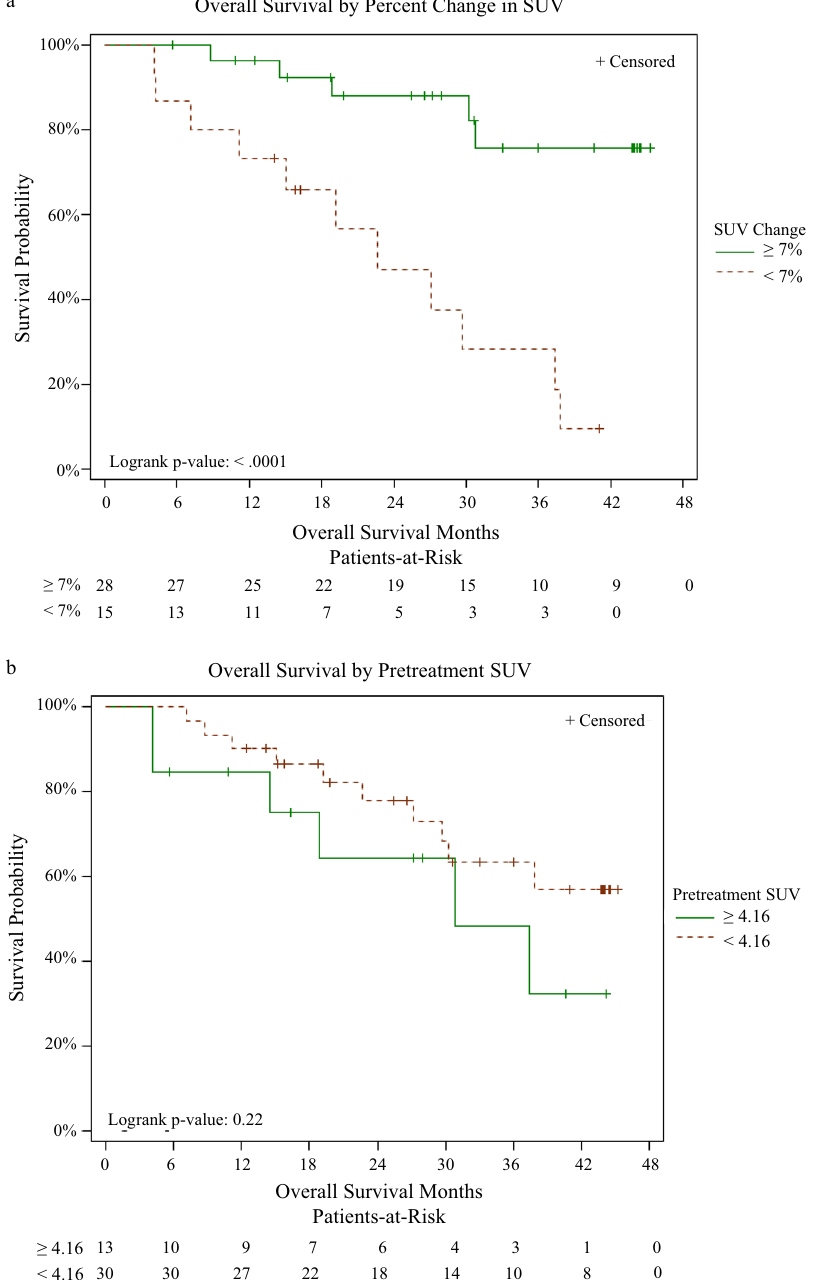
Fig. 5 Overall survival results. a Dichotomized based on percent change in standardized uptake value (SUV) for FFNP after estradiol challenge ( ≥ 7% vs. <7%). The overall survival results based on clinical response (responders versus nonresponders) were identical to those based on percent change in FFNP SUV. b Dichotomized based on the optimal cut-off value of the baseline FFNP SUV ( ≥ 4.16 vs.